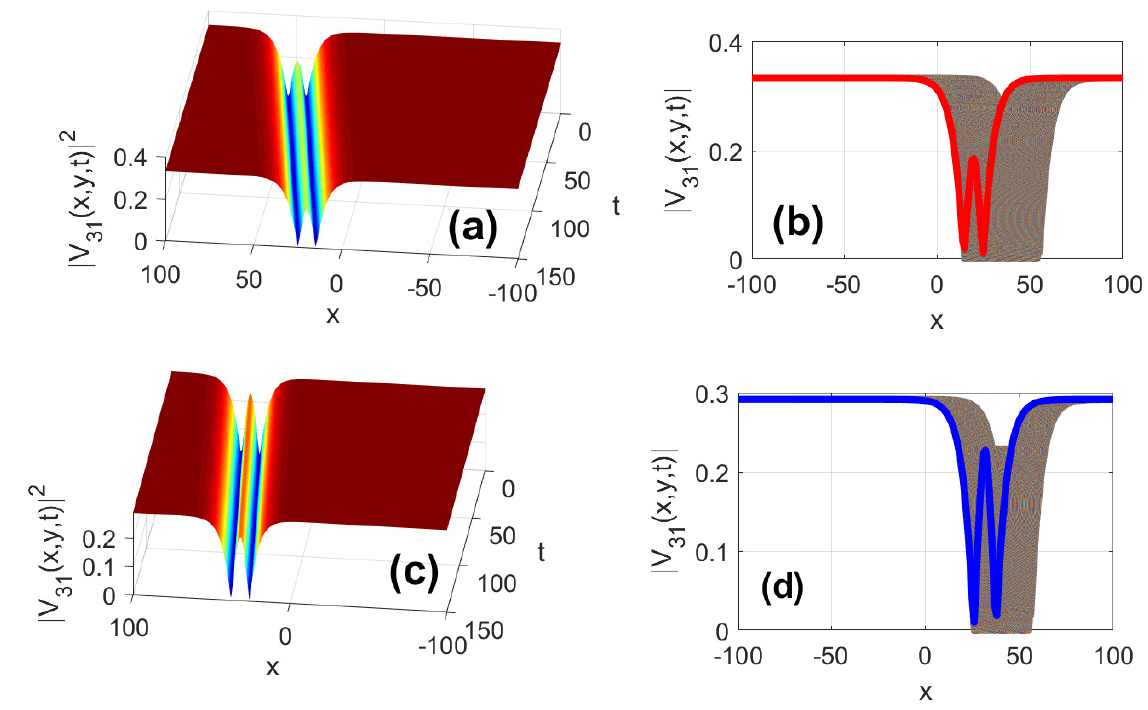
Figure 3. W-shaped evolution with variation in the potential parameter α . ( a – d ) are, respectively, the values of the potential parameter. ( a , b ) α = 0.3 V − 1 , ( c , d ) α = 0.35 V − 1 . The parameters used are ϑ 0 = 0.2, β = 0.019 V − 1 , B 1 = 0.02, y =